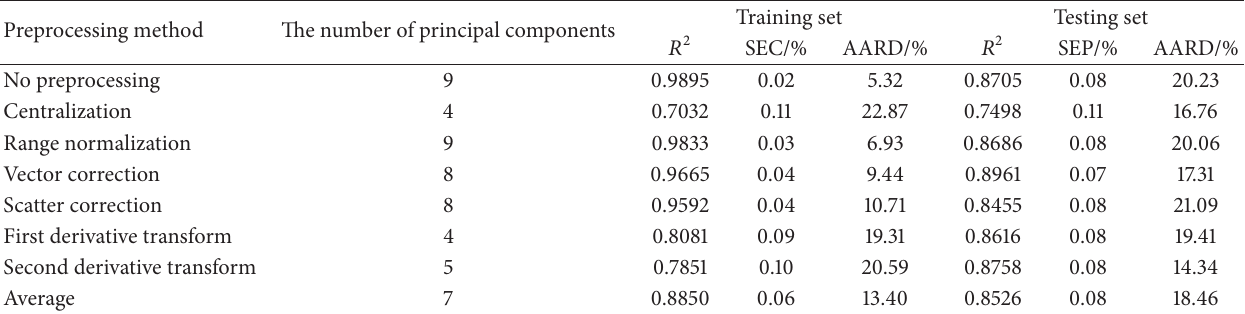
Table 1: Influence of different preprocessing methods of the near infrared spectra on prediction results of QPLS models for quantitative determination of germinability of Puccinia striiformis f. sp. tritici